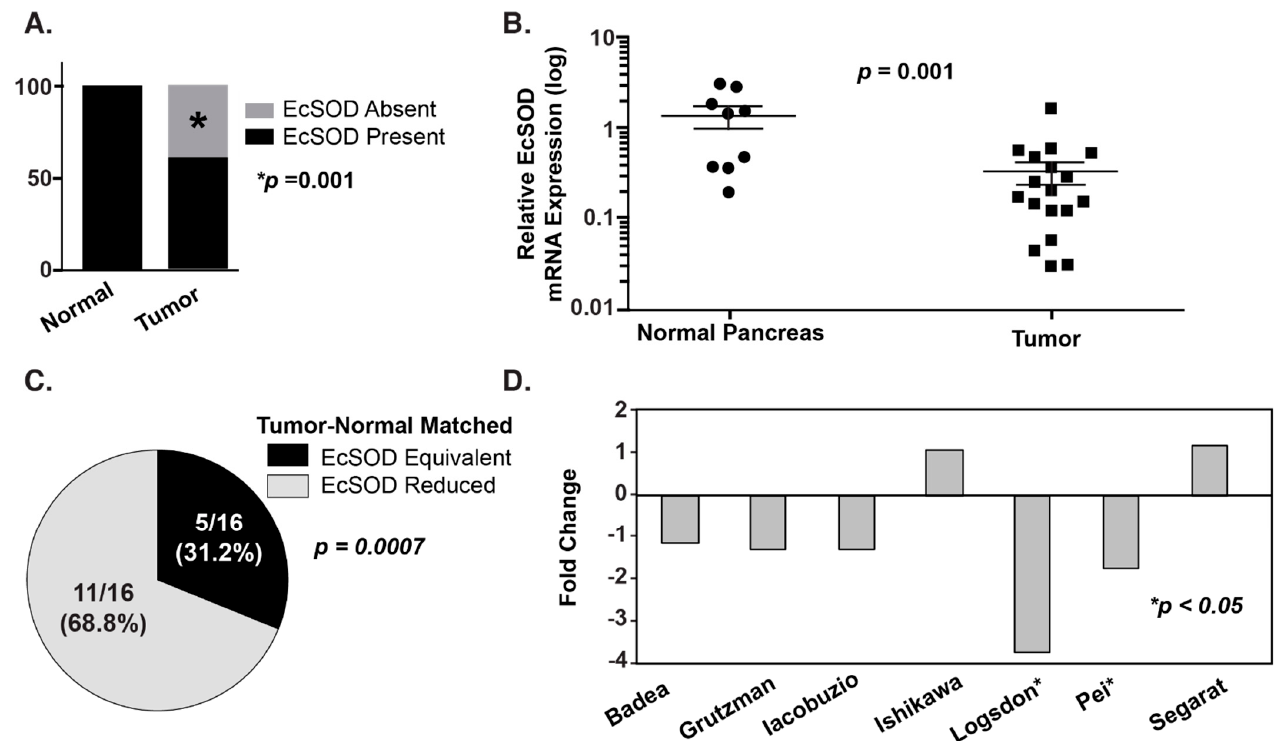
Figure 1. EcSOD expression is significantly decreased in pancreatic ductal adenocarcinoma (PDA) relative to normal pancreatic ductal epithelium. ( A ) EcSOD expression was evaluated by immunohistochemistry (IHC). EcSOD expression was scored as present or absent. All core biopsies from normal pancreatic ductal epithelium, 28/28 (100%), had high EcSOD expression, while 18/44 core biopsies from PDA lacked EcSOD expression (41%). p = 0.001. ( B ) EcSOD mRNA expression is significantly reduced in tumor compared to normal pancreas. The data were normalized to β -actin expression and are presented as fold-change (log scale) of tumor samples compared to normal pancreas. ( C ) IHC was performed on surgical specimens from PDA patients. Areas of normal pancreas showed intact EcSOD expression in all cases, while malignant ductal epithelium showed reduced EcSOD expression in 11/16 specimens p = 0.0007. ( D ) Analysis of existing Oncomine data revealed a consistent decrease in EcSOD mRNA expression relative to normal pancreas in 5/7 studies; 2 studies were highly significant [39].